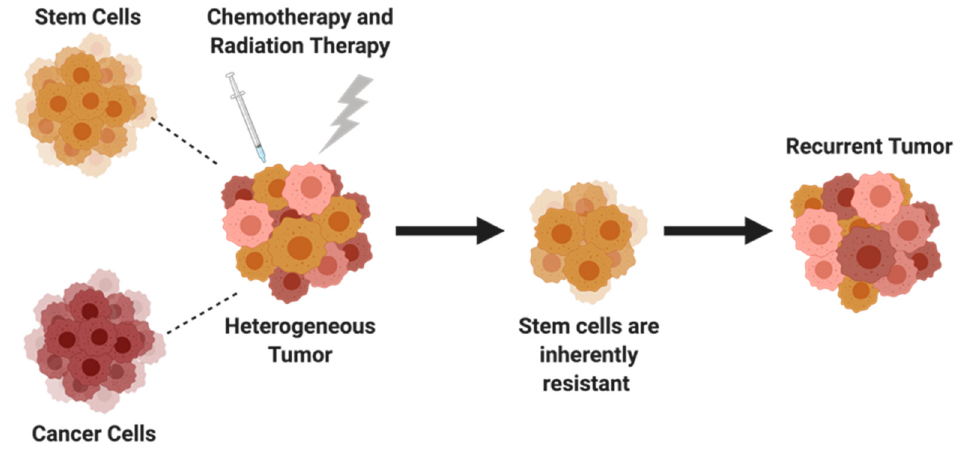
Figure 4. Scheme of cancer stem cells (CSCs) depicting the role of CSCs in ovarian cancer recurrence. CSCs are inherently resistant to chemotherapy and radiation and remain in the tumor tissue after treatment, causing tumor cell production and tumor recurrence. Tumor cells (red), CSCs (yellow).